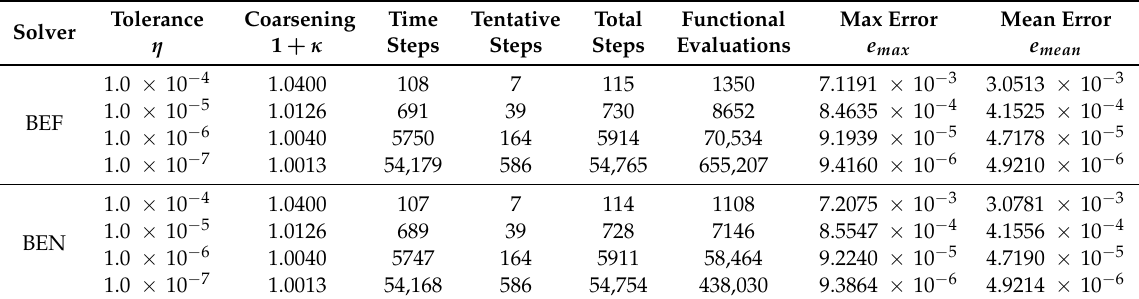
Table 3. Shifted quasilinear iterative splitting method for Bernoulli’s